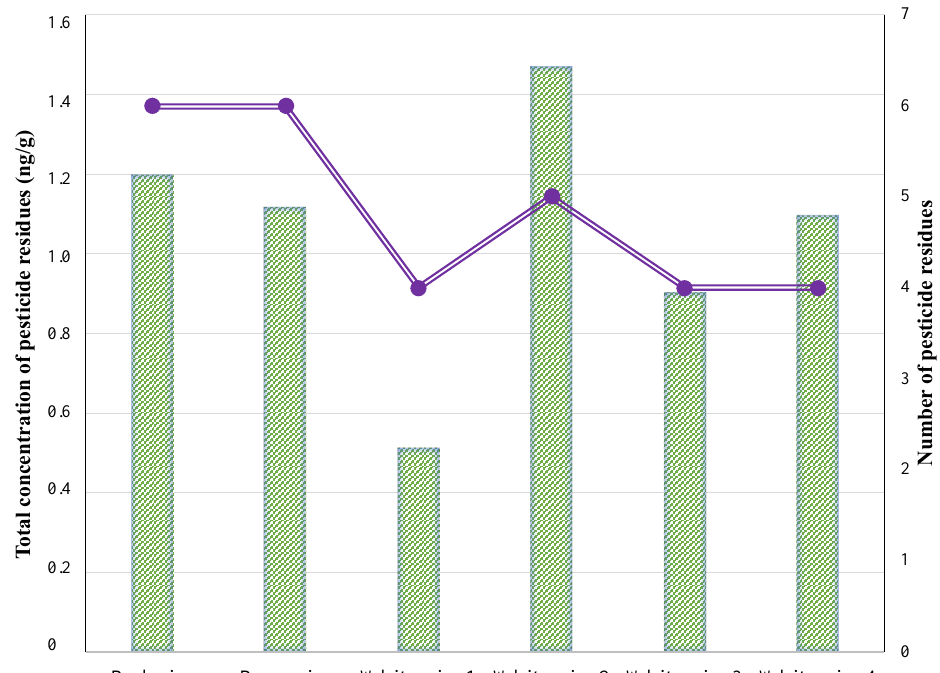
Figure 2. The total concentration and number of pesticide residues in each wine sample (original).